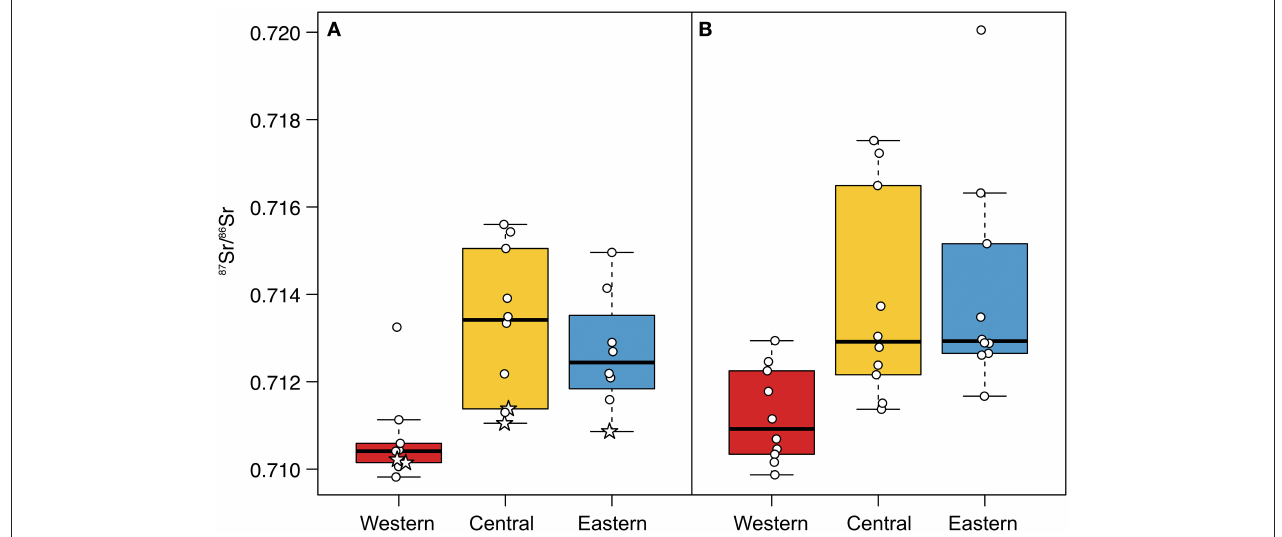
FIGURE 6 | Distributions of 87 Sr/ 86 Sr for (A) historical and (B) recent female antlers from the Western, Central, and Eastern Coastal Plain. Stars identify 87 Sr/ 86 Sr for antlers grown prior to 1900CE. Boxplots illustrate the interquartile range (box), 1.5 times the interquartile range (dashed whiskers), and median (thick black bar). Points (female antler 87 Sr/ 86 Sr) are offset to aid visibility.